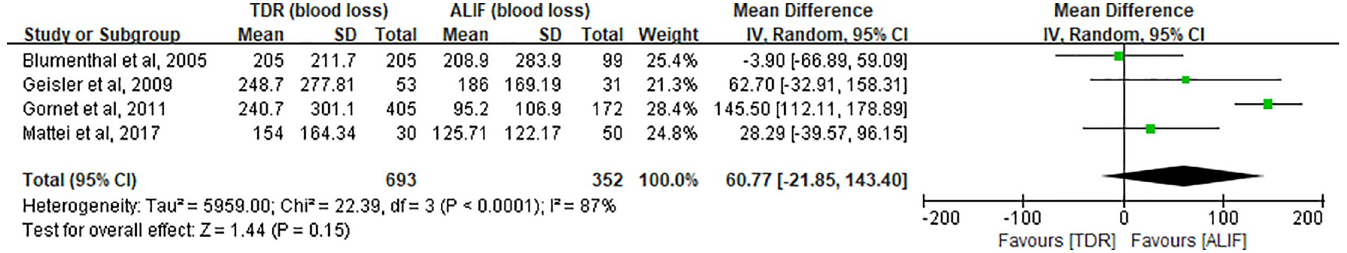
Fig 4. Forest plot for estimated blood loss. df = degrees of freedom, and IV = Inverse Variance.